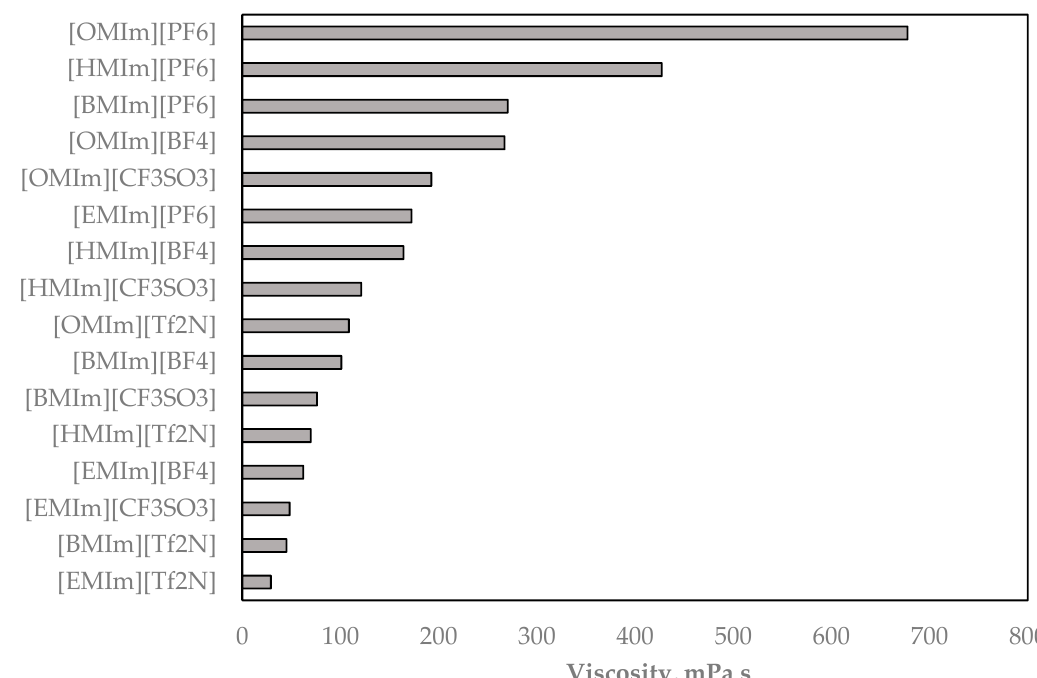
Figure 4. Figure showing the comparison of viscosity of air and water-stable ILs as a function of chain length at 298 K.